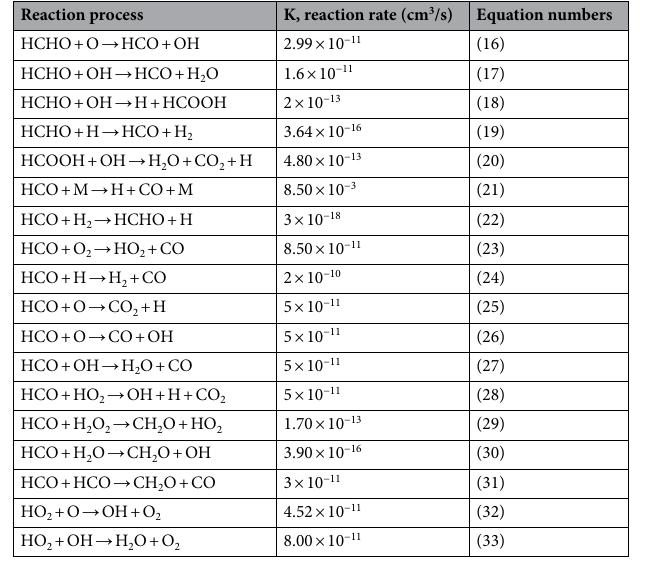
Table 3. Intermediate chemical reactions in the degradation of HCHO leading to the formation of CO 2 and H 2 O.